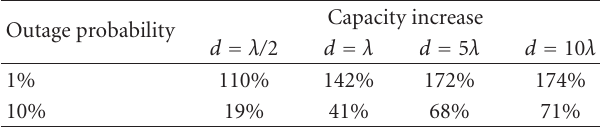
Table 3: Cellular capacity increase by using hybrid FRF ( Δ = 30 ◦ ). Outage probability